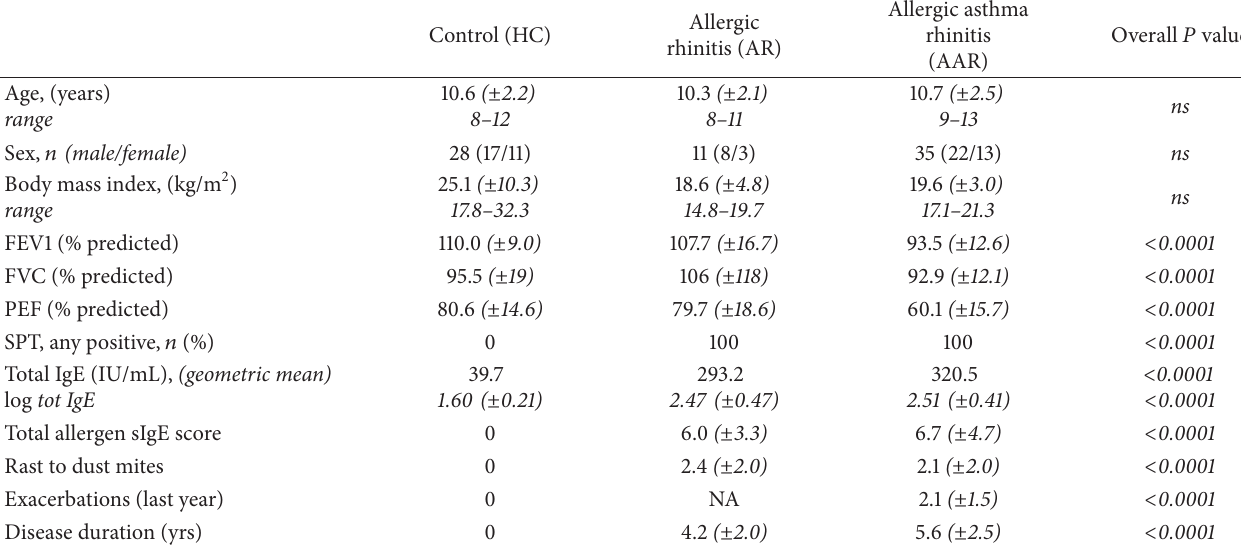
Table 1: Demographic, clinical, and atopic characteristic of the subjects. Allergic Control (HC) rhinitis